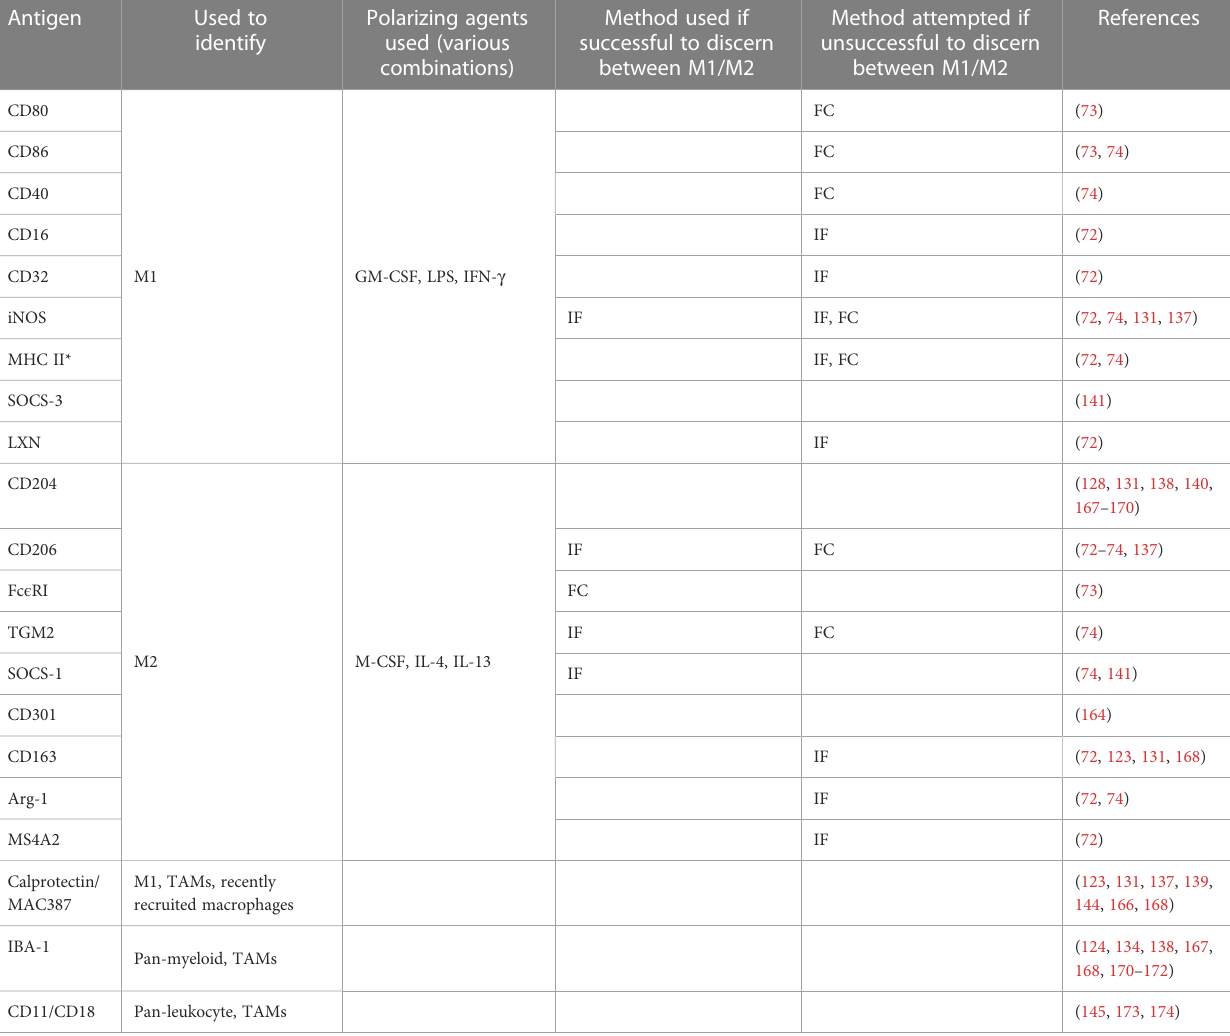
TABLE 3 Markers investigated in the veterinary literature for canine macrophages. Antigen Used to Polarizing agents identify used (various